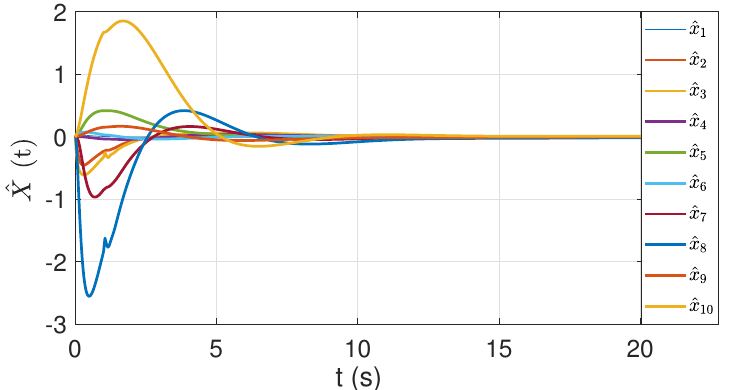
Figure 6. NCS system under a TDS attack of τ = 0.2 s at the instant t 0 = 1 s with the Luenberger observer operating to compensate the errors.